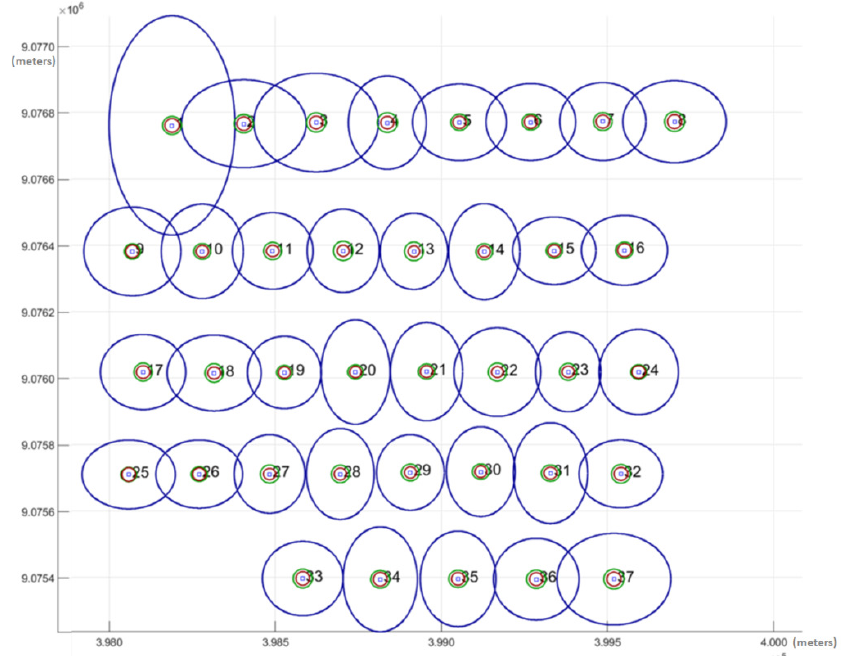
Figure 7. The plotted planimetric exterior parameters (X and Y) standard deviation values for each camera. Red circles denote Inpho results, green ERDAS results, and blue DBAT results from PhotoScan project. The radii are magnified by 500 times.